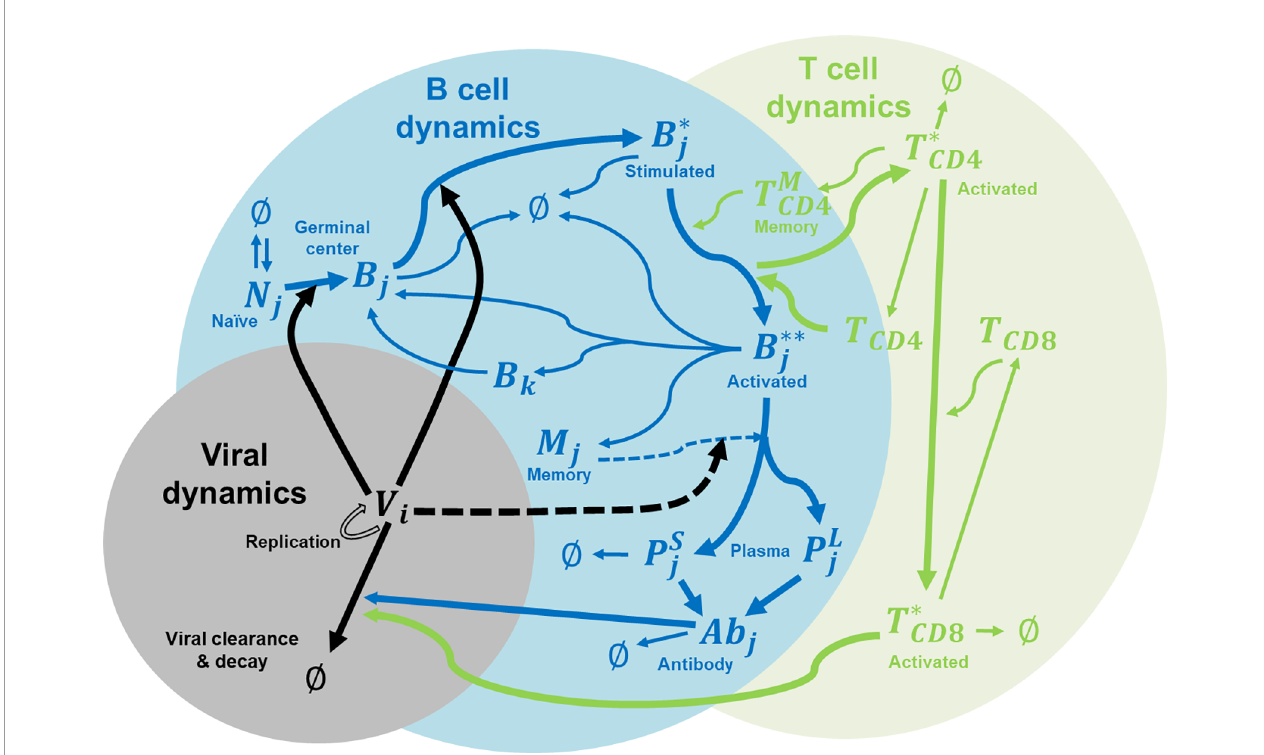
FIGURE 1 | Immune system model for af fi nity maturation. A summary of the immune system model that is used to simulate af fi nity maturation, including B and T cell stimulation, proliferation, mutation, differentiation, Ab production, and virus replication and clearance. The components in the model include naïve B cells ( N ), germinal center B cells ( B ), stimulated B cells ( B* ), activated B cells ( B** ), memory cells ( M ), plasma cells ( P as short-lived, S , and long-lived, L ), virus (V), CD4 + T cells ( T CD4 ), activated CD4 + T cells ( T* CD4 ), memory CD4 + T cells ( T M CD 4 ), CD8 + T cells ( T CD8 ), activated CD8 + T cells ( T* CD8 ), and Abs. Subscript i denotes epitope genotype, j denotes paratope genotype, and k denotes mutated paratope